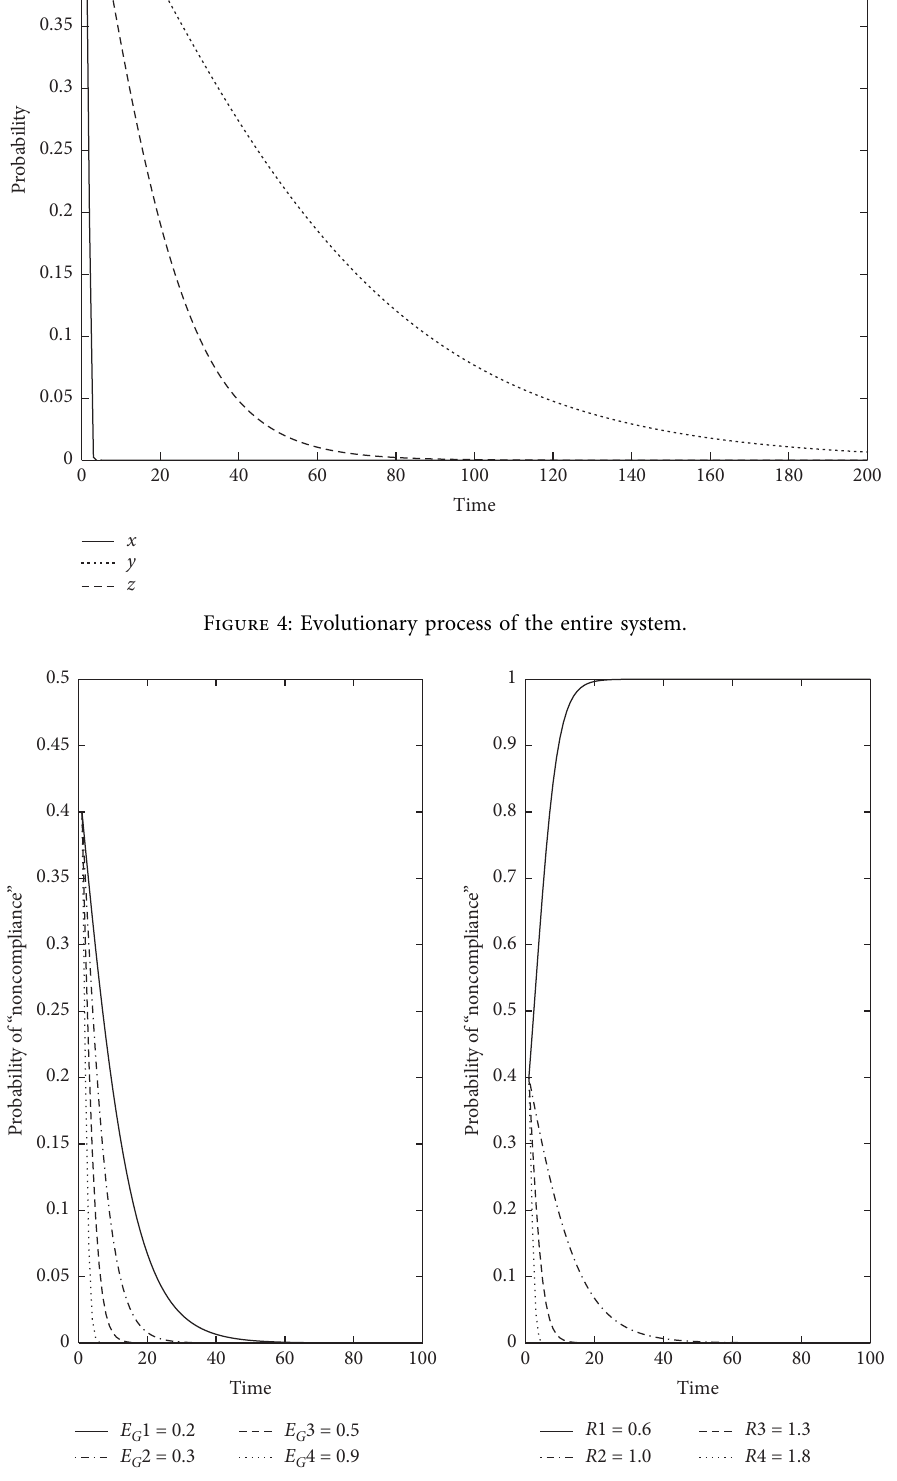
Figure 5: The effects of psychological costs and rent-seeking